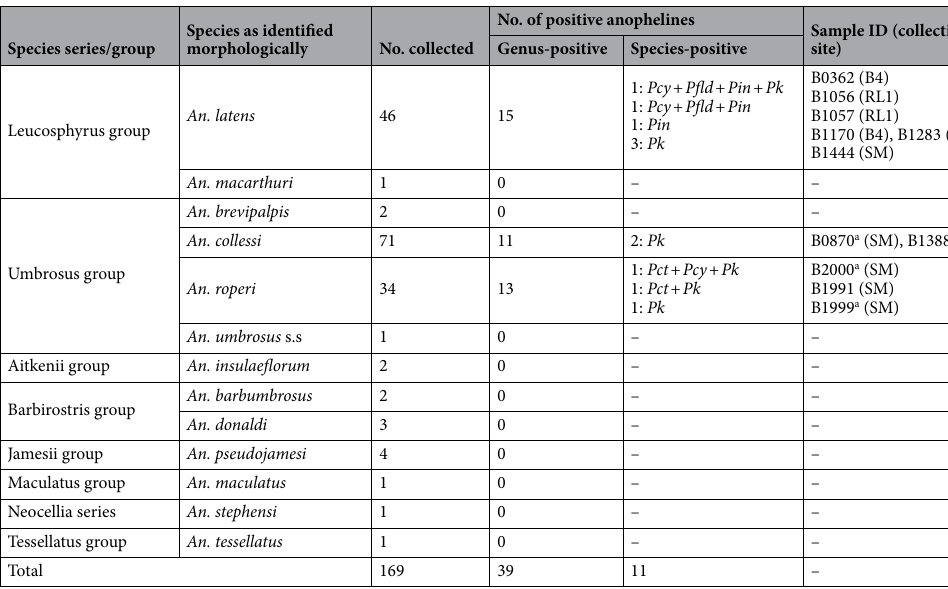
Table 1. Nested PCR results conducted on genomic DNA extracted from mosquito salivary glands. a Samples which were collected in the morning (0600–1100